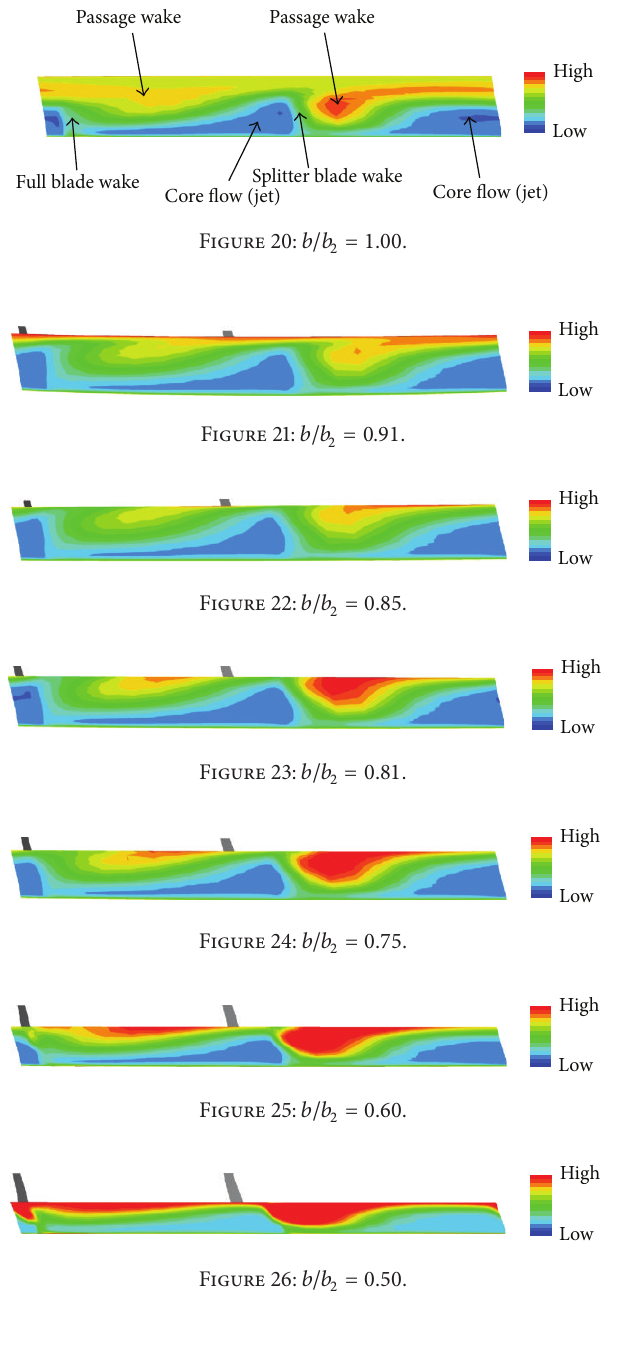
Figure 26: 𝑏/𝑏 2 = 0.50